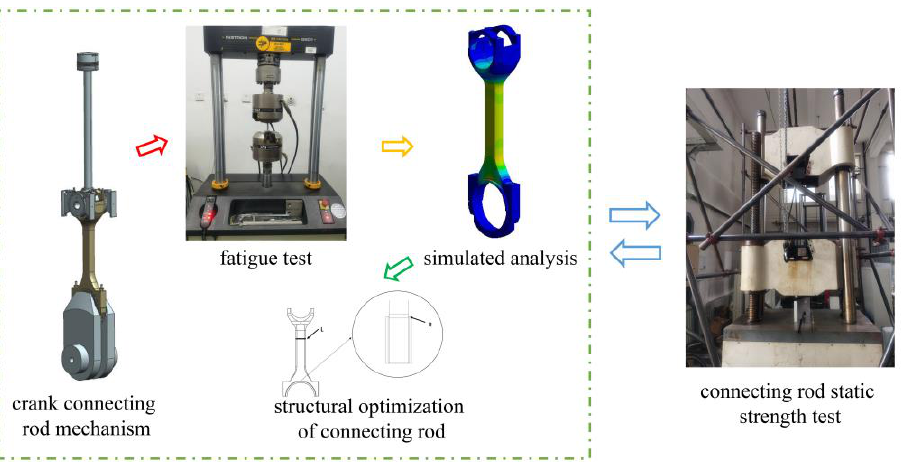
Figure 1. Overall diagram of structural optimization design and strength test of connecting rod assembly of high-power low-speed diesel engine.